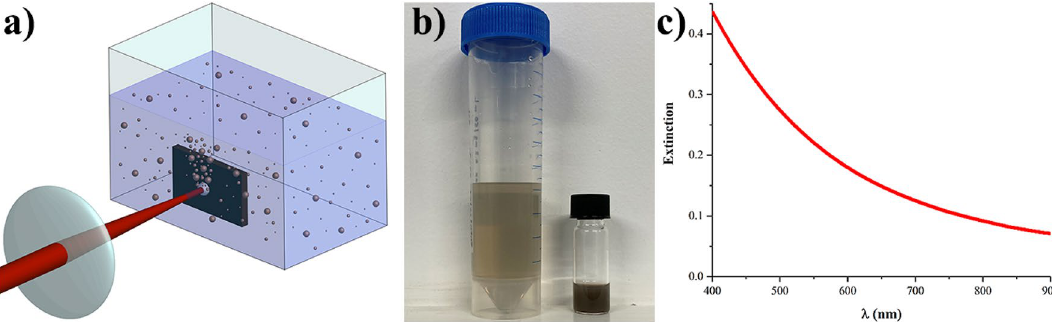
Figure 1. Boron NPs produced by laser ablation in deionized water. ( a ) Schematic of laser ablation experiment. ( b ) Initial (left) and concentrated (right) solutions of laser-ablated B NPs in deionized water. ( c ) Extinction spectrum from a colloidal solution of B